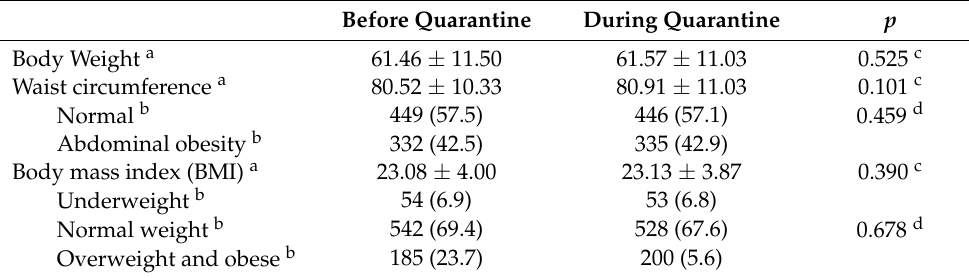
Table 3. Anthropometric parameters in subjects included in the surveillance study. Before Quarantine